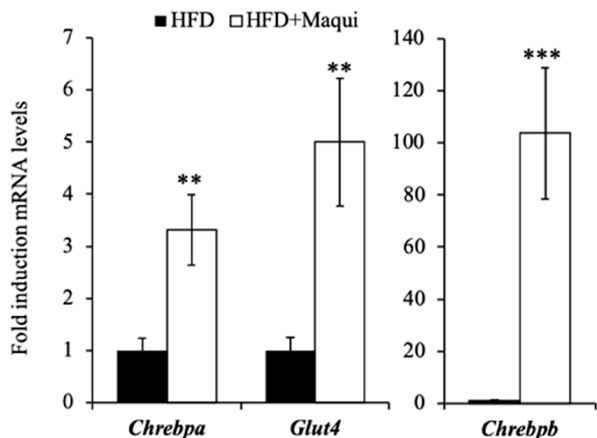
Figure 4. Maqui induces the expression of Chrebpa, Chrebpb and Glut4 in scWAT. The relative mRNA levels of Glut4, Chrebpa and Chrebpb were measured by qRT-PCR in scWAT of HFD and HFDM mice. Bars represent the fold induction in the mRNA levels versus the HFD animals that are considered the control group and assigned an arbitrary value of 1. Data are presented as the mean ± SEM. ** p < 0.01, *** p < 0.001 versus the HFD group.